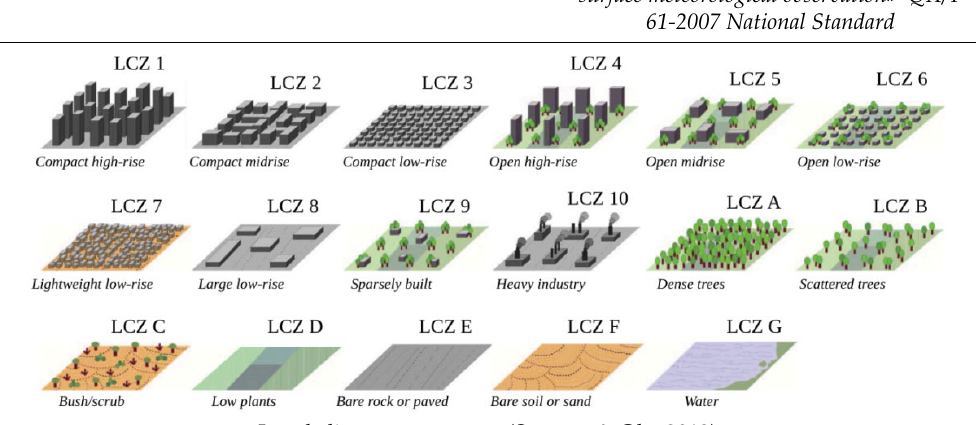
Table A2. Xinzheng national weather station LCZ.